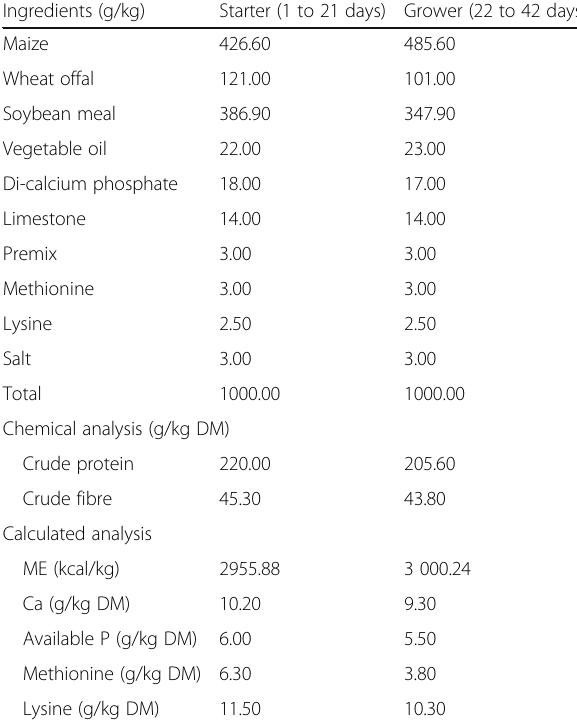
Table 2 Composition and nutrient content of